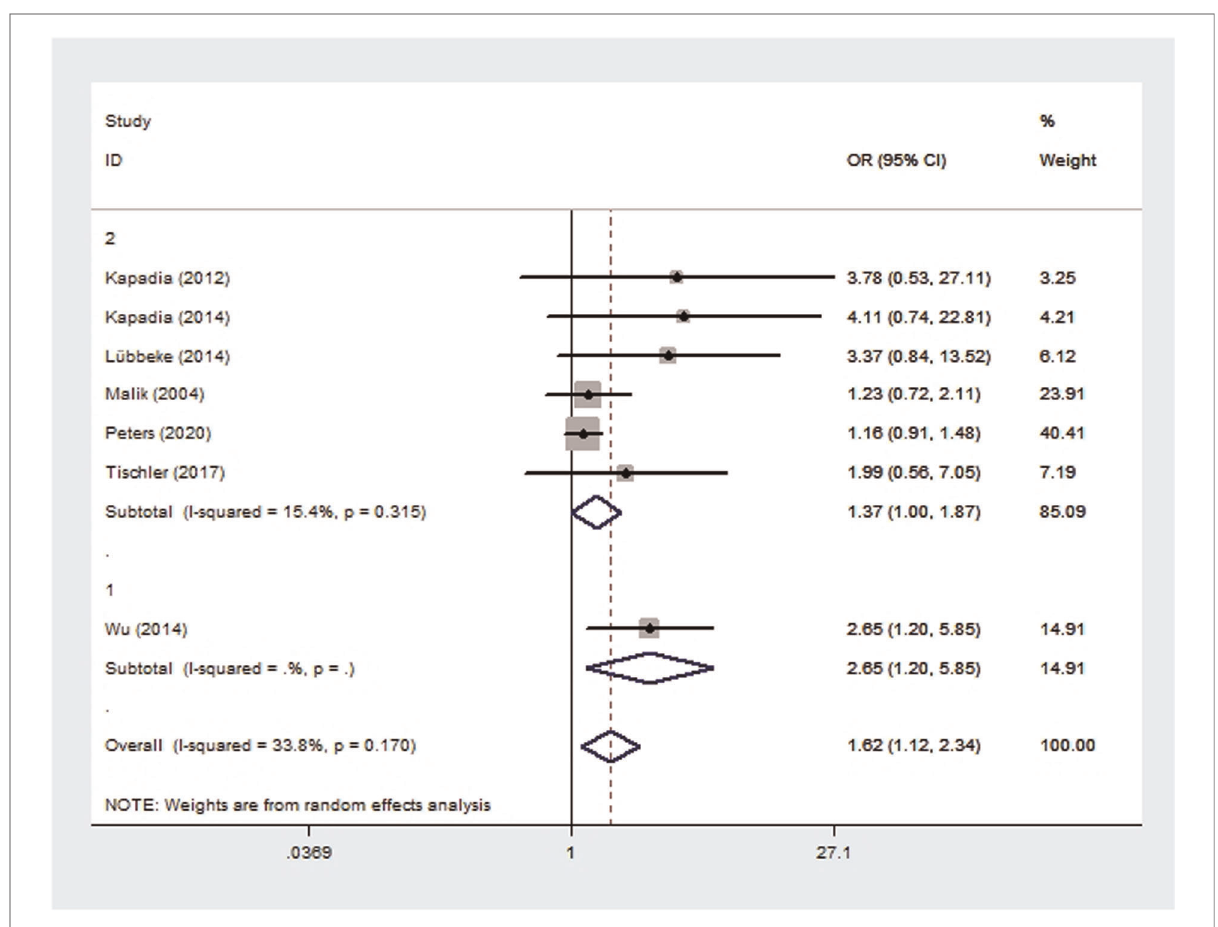
FIGURE 4 Forest plot of subgroup analysis for aseptic loosening based on study type (1: case-control study; 2: cohort